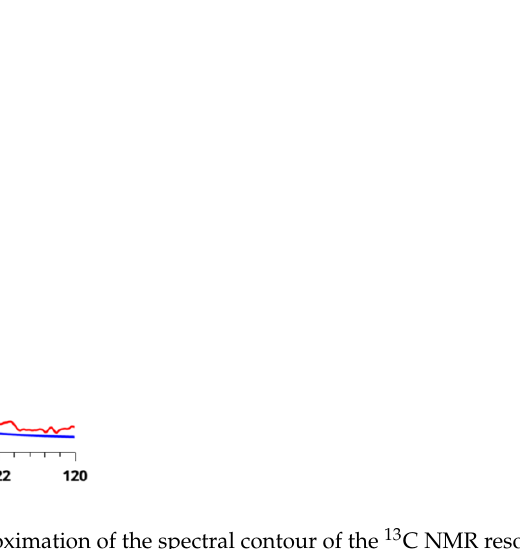
Figure 5. An example of quality of approximation of the spectral contour of the 13 C NMR resonance signals of CO 2 and standard C 6 D 6 (red line) by Lorentz-like profiles (blue line) using pseudo-Voigt functions.